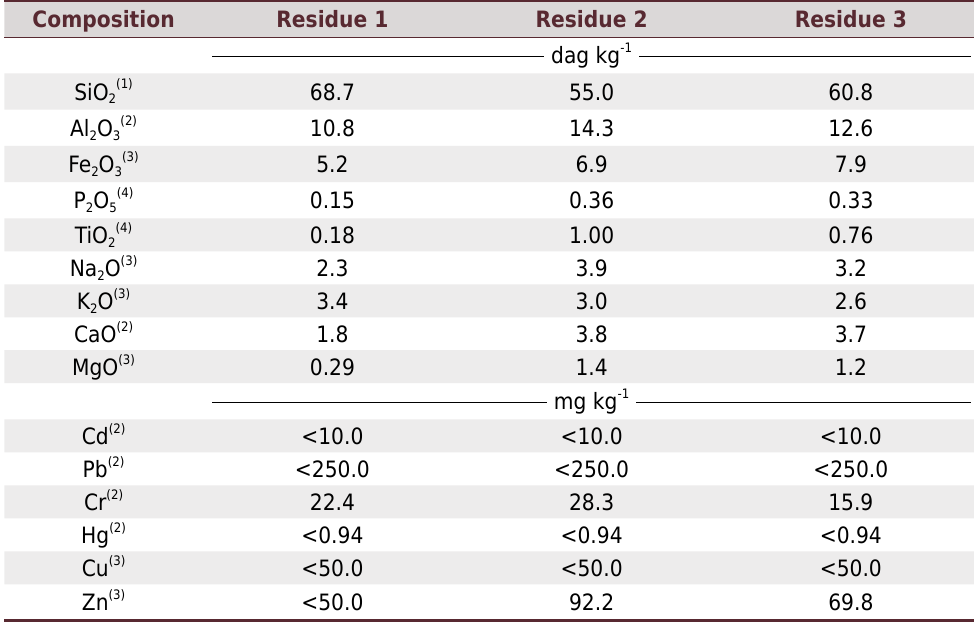
Table 1. Chemical composition of the ornamental rock